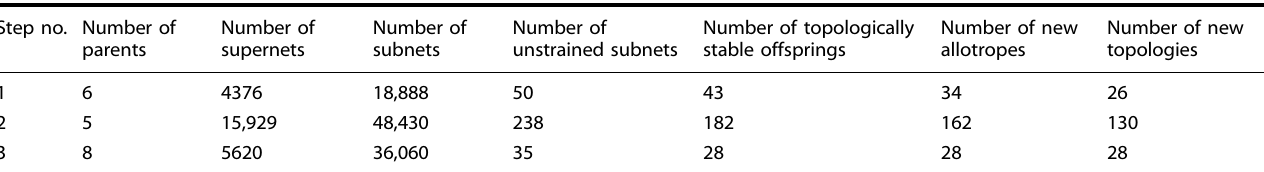
Table 1. The results of scanning the con fi guration space of carbon